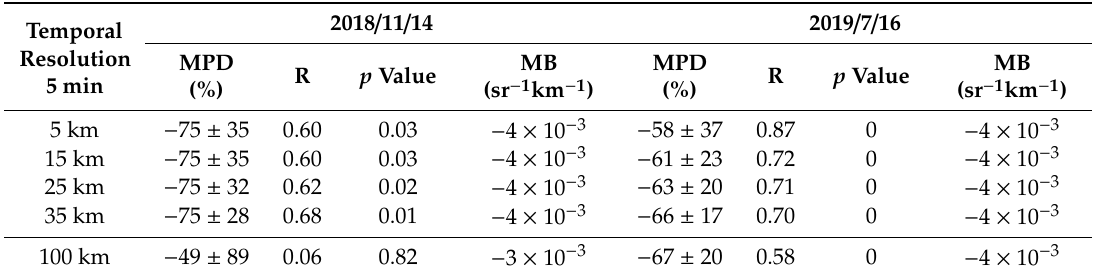
Table A3. Statistical results (Mean Bias (B), Correlation Coe ffi cient (R) and p value) derived from simultaneous measurements between CALIOP and Mace Head data for a cloud–free case (18 / 11 / 14) and for a case with a thin cloud (19 / 07 / 16) considering di ff erent along–track averages in CALIOP data (5 km, 15 km, 25 km, 35 km, and 100 km) and 5 min temporal resolution in Mace Head data.